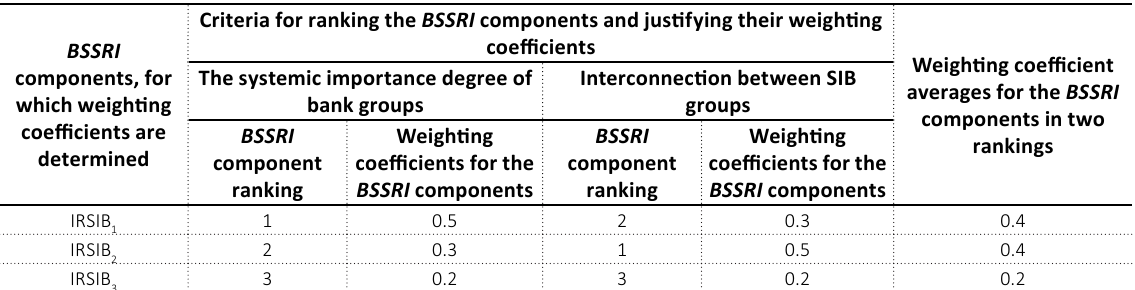
Table 3. Determination of weighting coefficients for the aggregated systemic risk indicator components in the banking